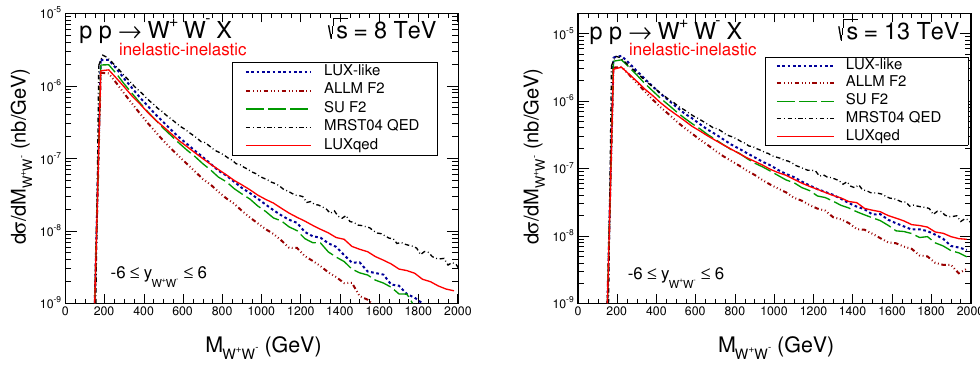
Figure 2 . The inelastic-inelastic contribution to W + W (cid:0) invariant mass distributions for di(cid:11)er- ent structure functions: LUX-like, ALLM97, SU compared to the relevant collinear distributions: MRST04 QED, LUXqed. The left panel shows results for p results for s = 13 TeV.